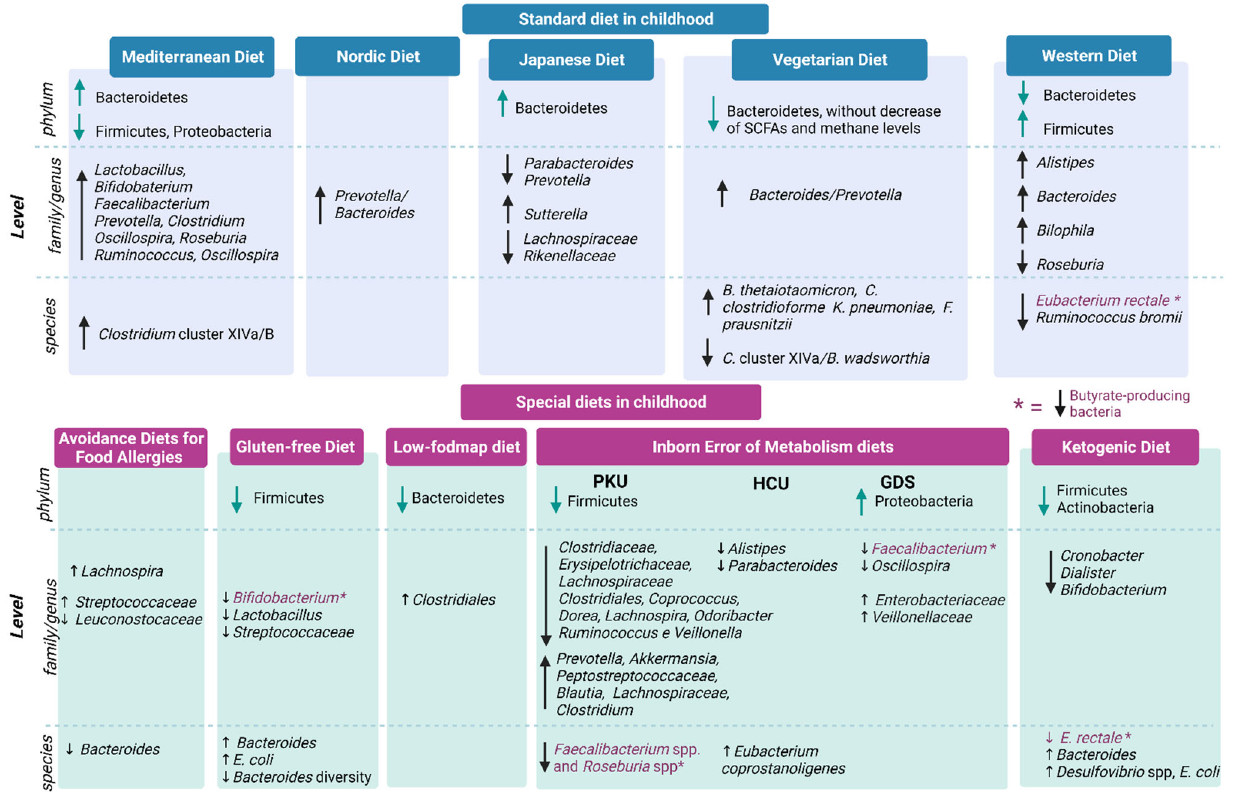
Figure 2. Gut microbiota composition in children with standard diets vs. special diets. ↓ = decrease in family/genus or phylum; ↑ = increase in genus/family or phylum